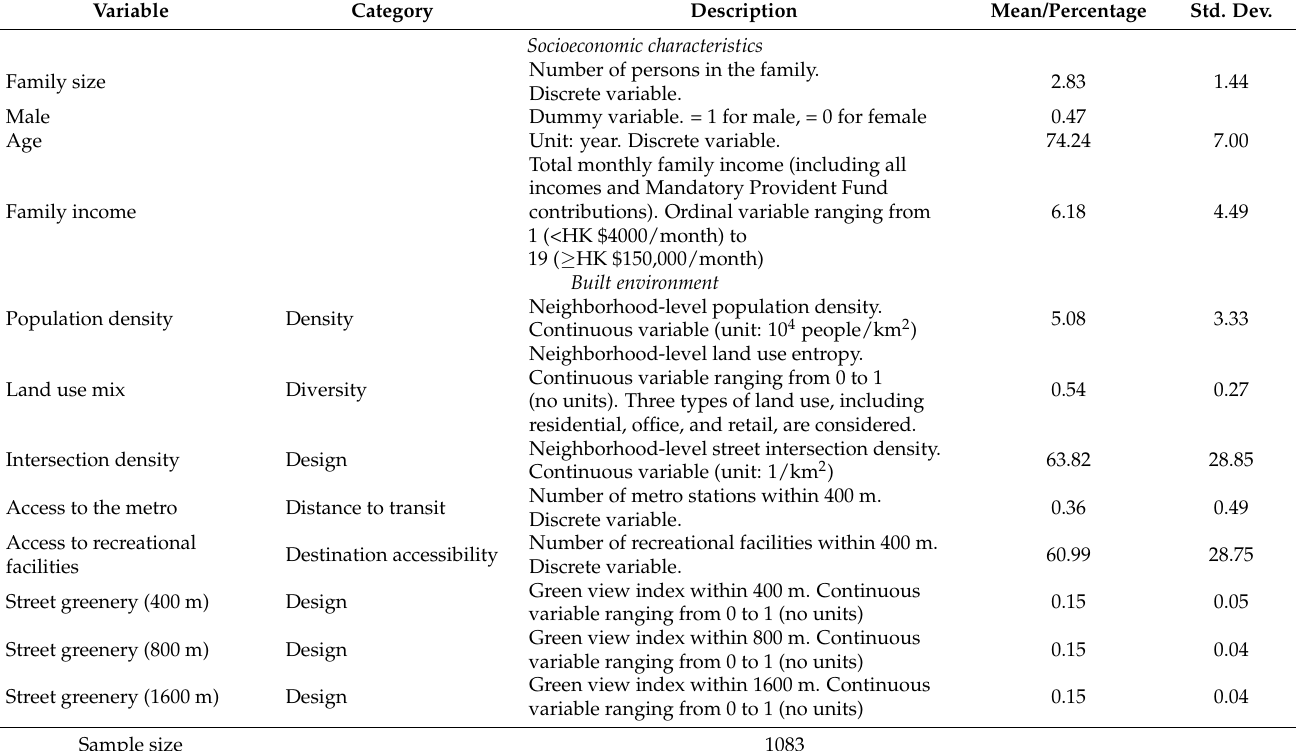
Table 1. Summary of the independent